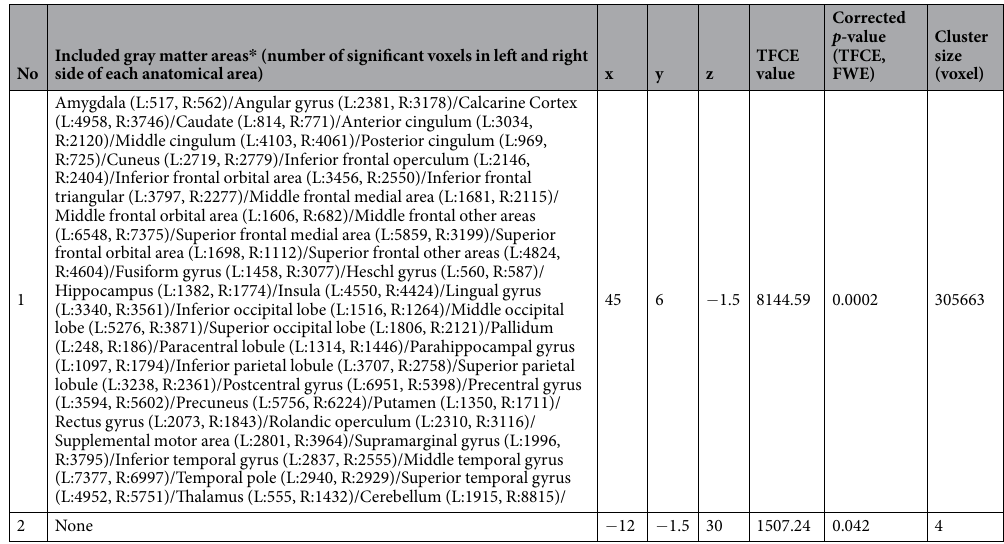
Table 3. Brain regions exhibiting significant correlations between digit span scores and rGMV. * Labeling of anatomical gray matter regions was based on the WFU PickAtlas Tool (http://www.fmri.wfubmc.edu/cms/ software#PickAtlas/) 68, 69 and the PickAtlas automated anatomical labeling atlas option 70 . Temporal pole and cerebellum include all subregions of these areas in the